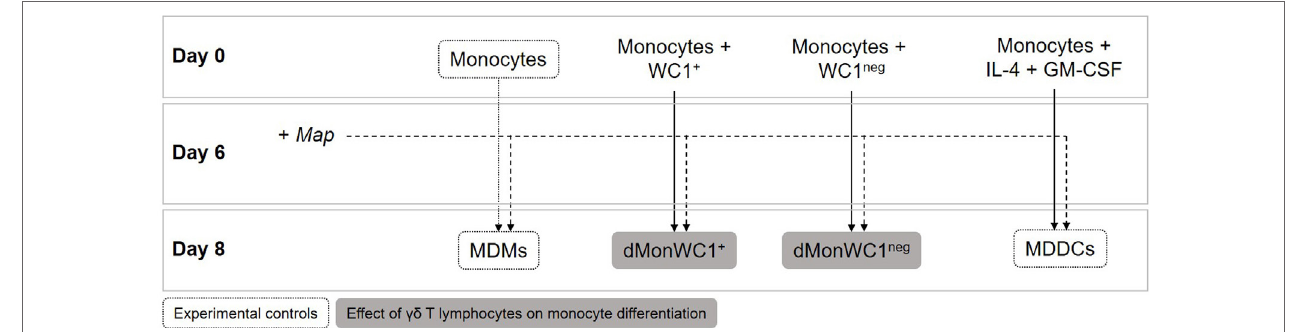
FigUre 1 | Monocyte differentiation assays . 1 × 10 6 WC1 + or WC1 neg γδ T lymphocytes were added directly to wells containing 2 × 10 5 monocytes the same day of peripheral blood mononuclear cell isolation (day 0). After 6 days of differentiation, cultures of monocyte-derived macrophages (MDMs), monocyte-derived dendritic cells (MDDCs), monocytes differentiated in presence of WC1 + (dMonWC1 + ) or WC1 neg (dMonWC1 neg ) γδ T lymphocytes were obtained. On day 6, live Map was added at a multiplicity of infection of 10:1 to evaluate how it affected phenotype of MDMs, dMonWC1 + and dMonWC1 neg ; and MDDC after 48 h.